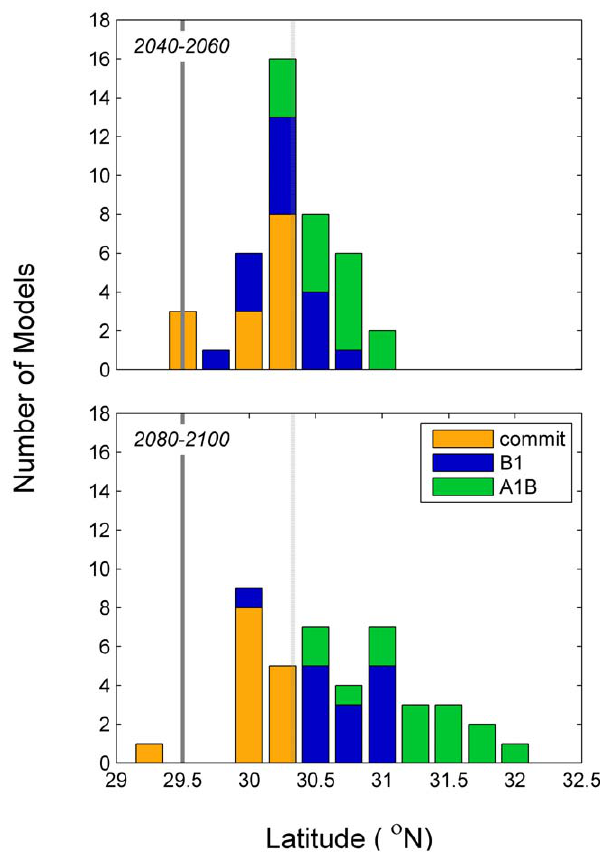
Figure 7. Estimated northern range limit of gray snapper during two time periods and under three emission scenarios. Results for each of the 14 GCMs are provided to present the range of projections that compose the ensemble. The heavy and light gray lines represent the estimate of current northern range limit and standard error as determined from field observations [39].